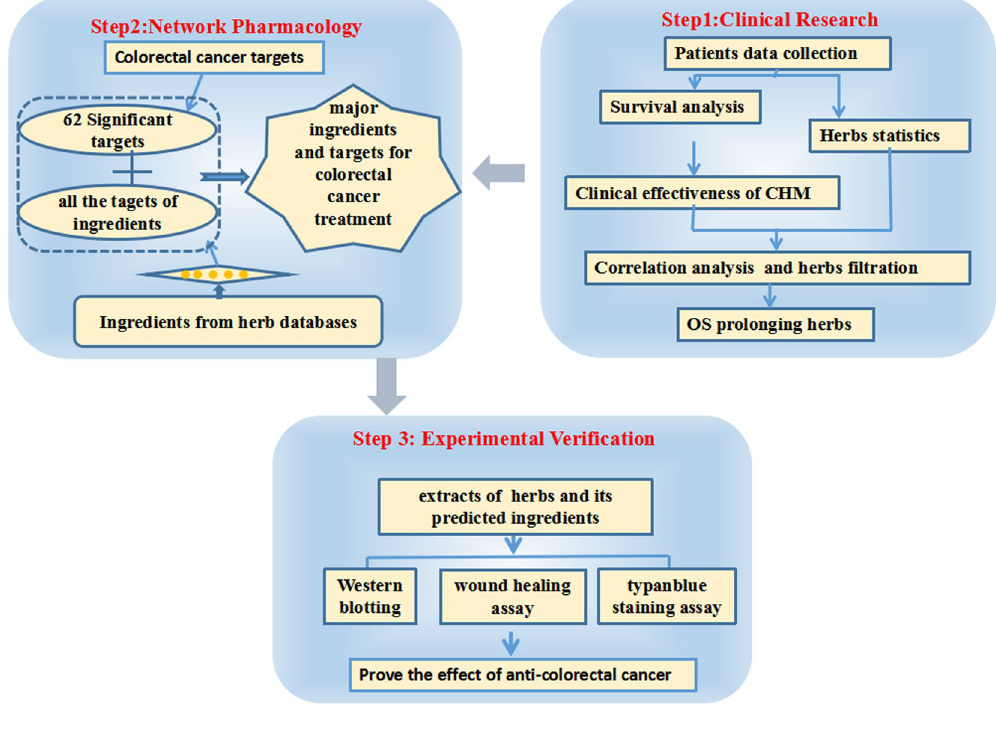
Figure 1. Process